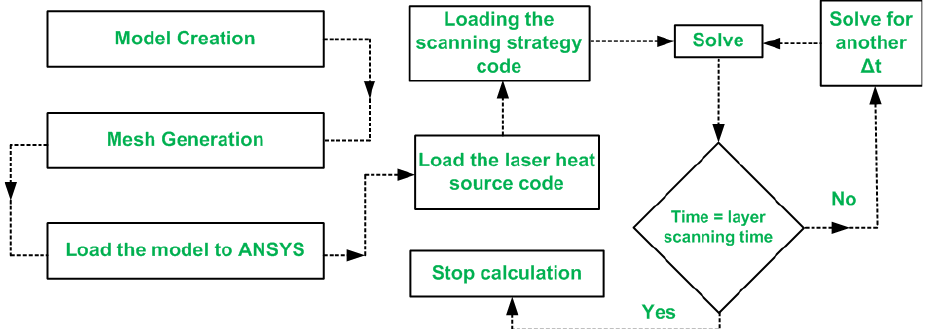
Figure 6 . Flowchart of the numerical model solution procedure.